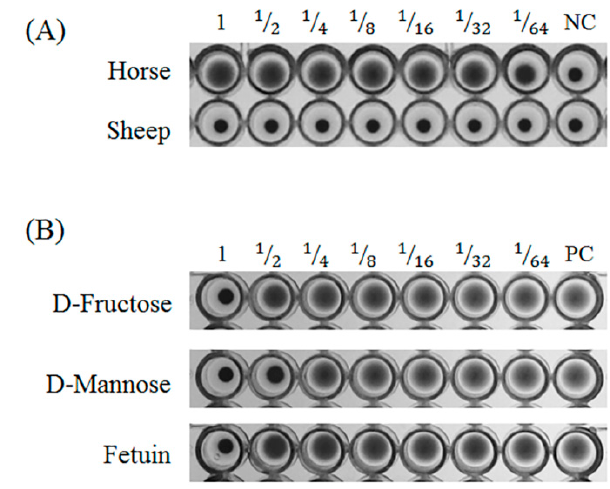
Figure 2. Hemagglutination assay and carbohydrate specificity of Grateloupia chianggi lectin (GCL). ( A ) Hemagglutination activity of GCL (25 µg/mL) in horse and sheep blood. ( B ) Carbohydrate specificity of GCL (four hemagglutination activity units of GCL were used for the inhibition test). A serial two-fold dilution was obtained (left to right); NC, negative control; PC, positive control. Table 3. Minimum inhibitory concentration of lectin by treatment of various substances.